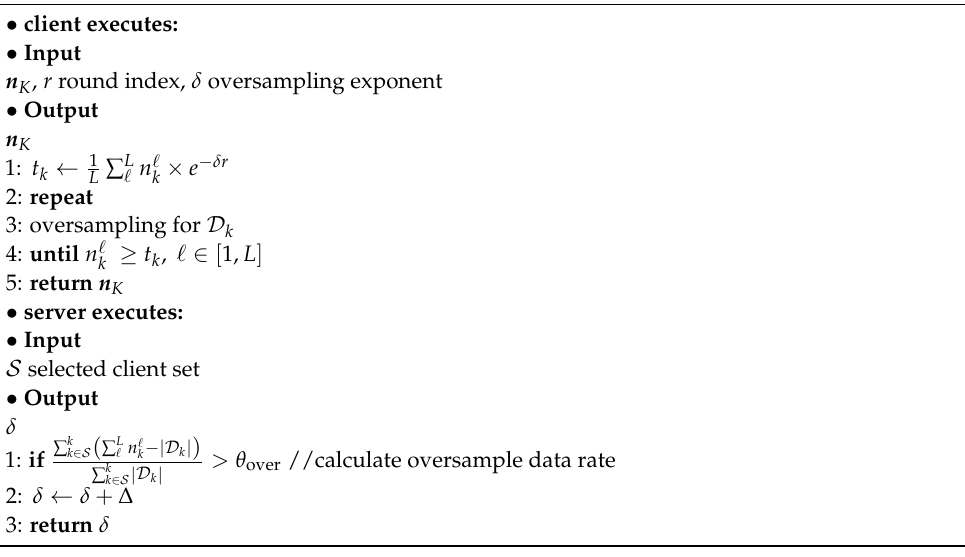
Algorithm 1. Sampling. number of data per class is greater than or equal to the